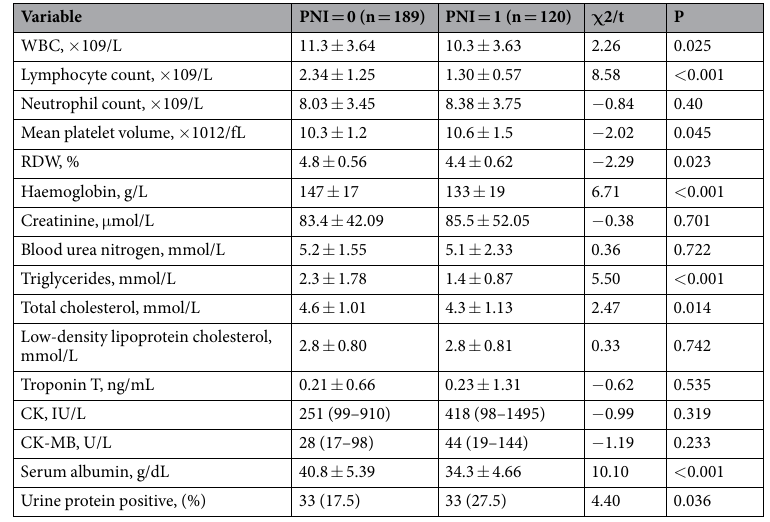
Table 2. Laboratory findings in STEMI patients after pPCI by PNI score group. WBC, white blood cell; RDW, red blood cell distribution; CK, creatinine kinase; CK-MB, creatinine kinase – myocardial band isoenzyme;